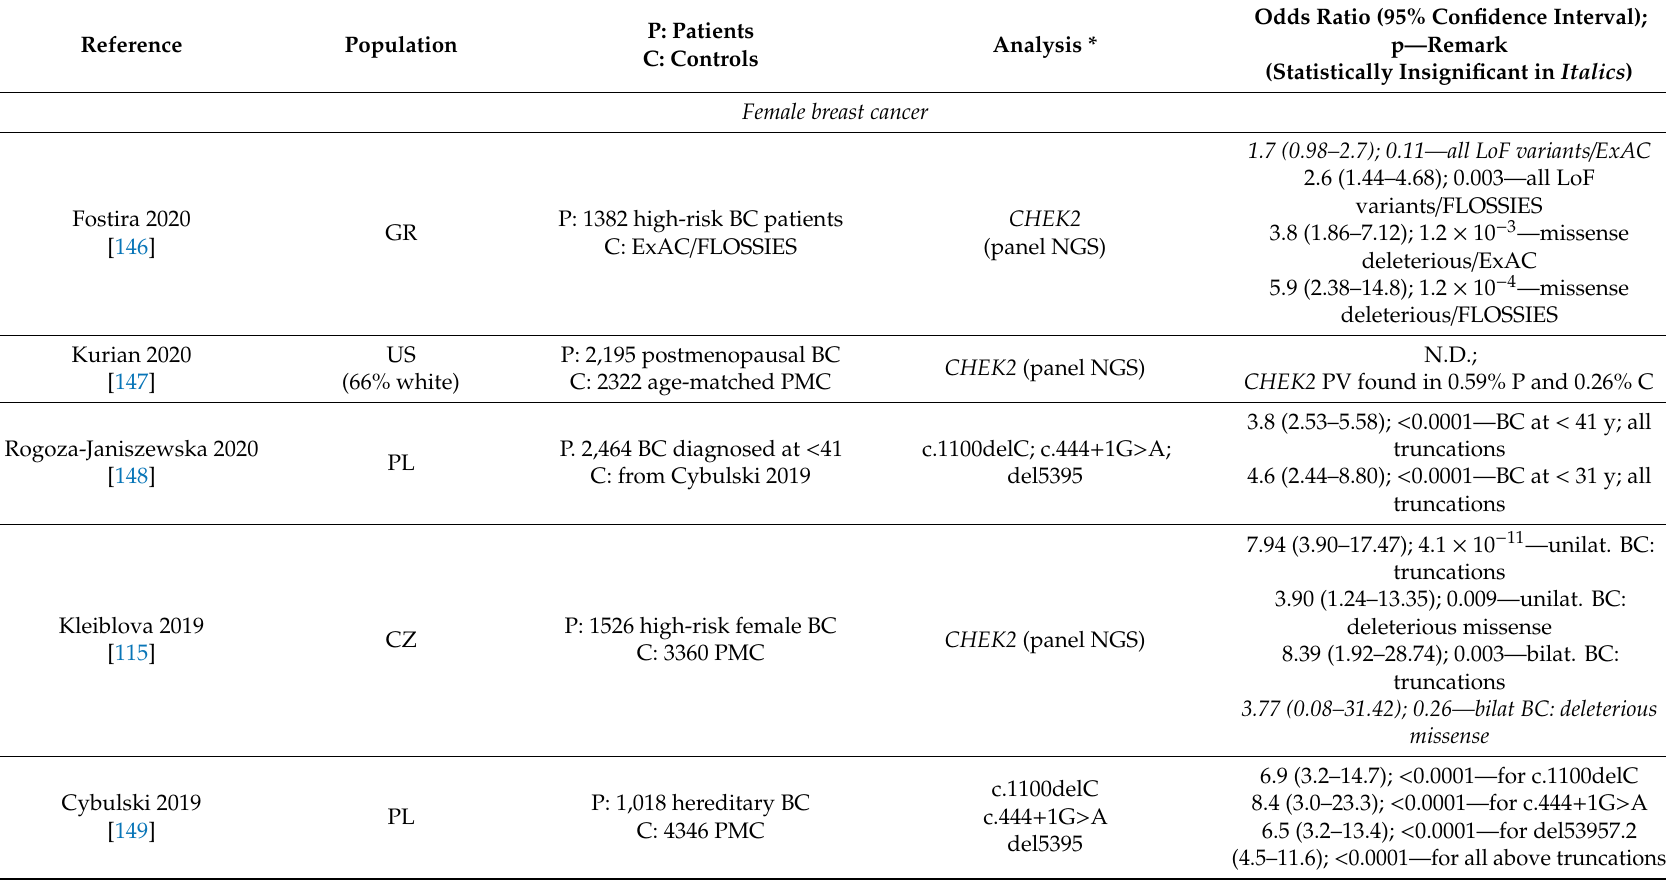
Table 1. Analyses of the entire CHEK2 coding sequence (separately or as part of panel next-generation sequencing (NGS)) or analyses of specific variant(s) in breast cancer (BC)